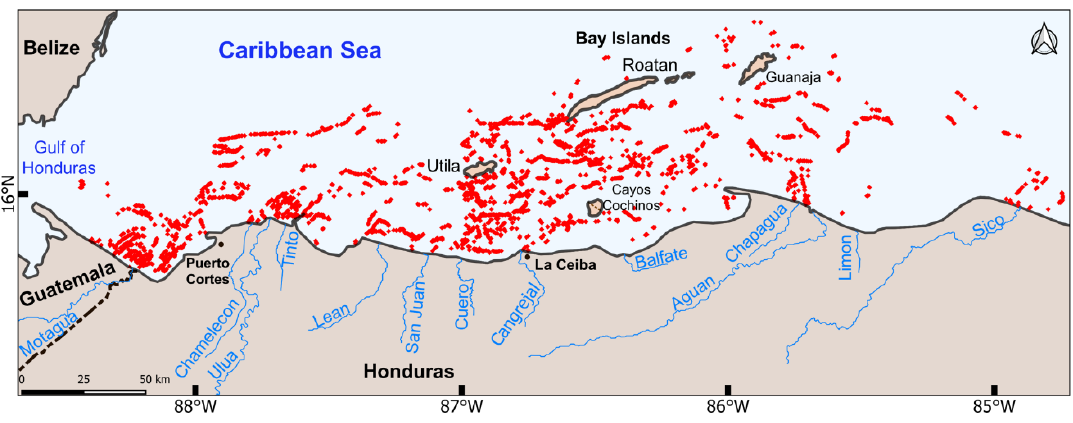
Figure 4. Total satellite-detected marine plastic debris from 2014 to 2019 in the southeast Gulf of Honduras and Bay Islands in the Caribbean Sea (red dots in the map). Plastics debris enters Caribbean Sea through river discharges. Plastic debris travels long distances dispersed in the entire study